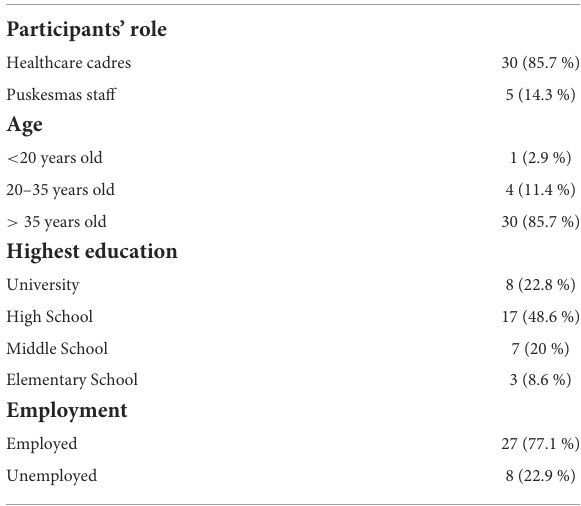
TABLE 1 Demographic profile of FGD participants ( N =